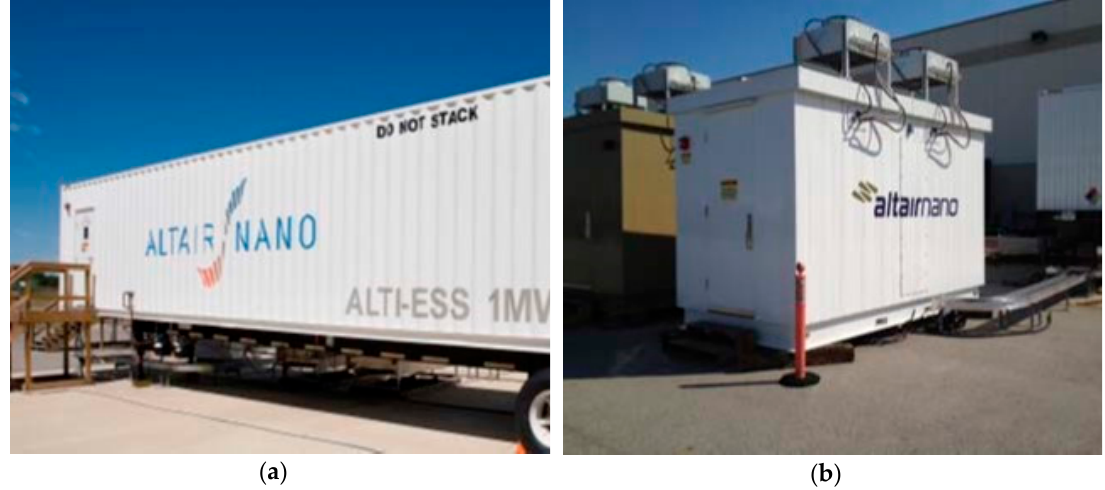
Figure 1. Containers for the BESS ( a ) power module (PM); and ( b ) power conversion system (PCS).